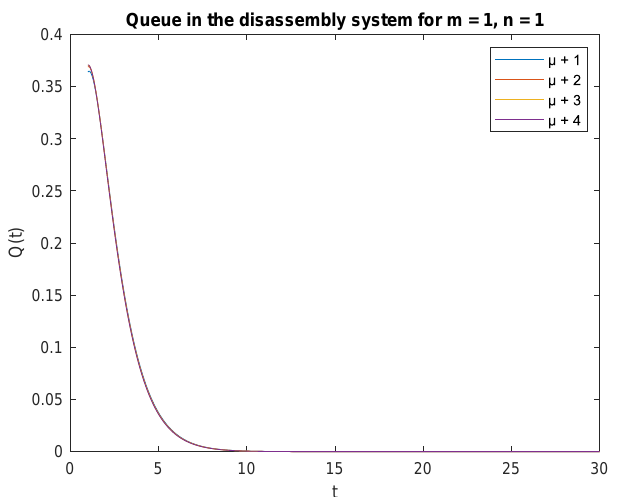
Figure 18. Impact of disassembly rate on probability P { X ( t ) = 1 | X ( 0 ) = 0 } for λ =